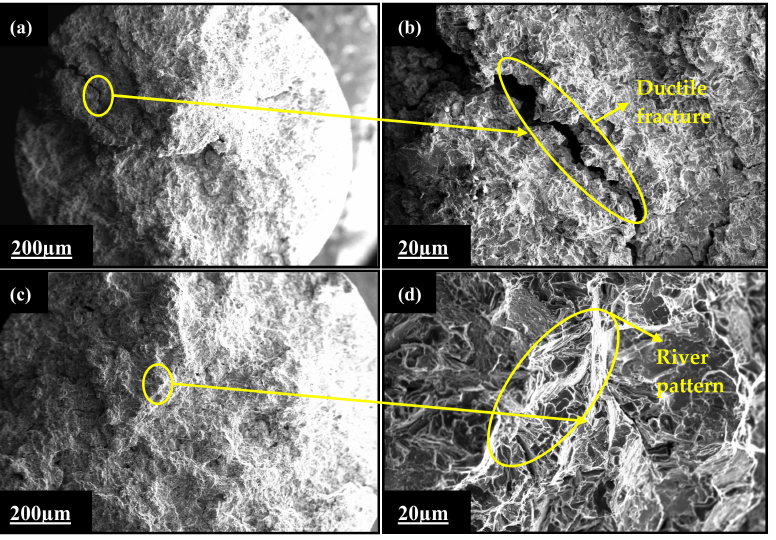
Figure 16. Fracture analysis of the ( a , b ) as-cast and ( c , d ) peak-aged LM4 alloy tensile sample.